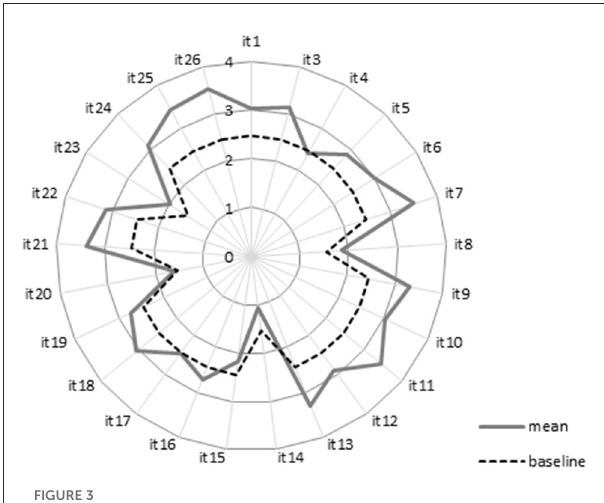
FIGURE3 Mean item score for the AUQEI given by